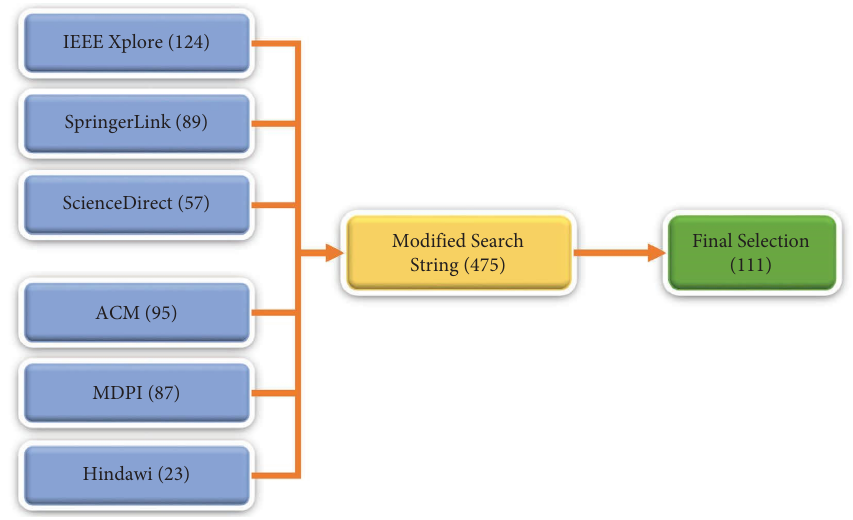
Figure 3: Paper selection process from diferent databases.